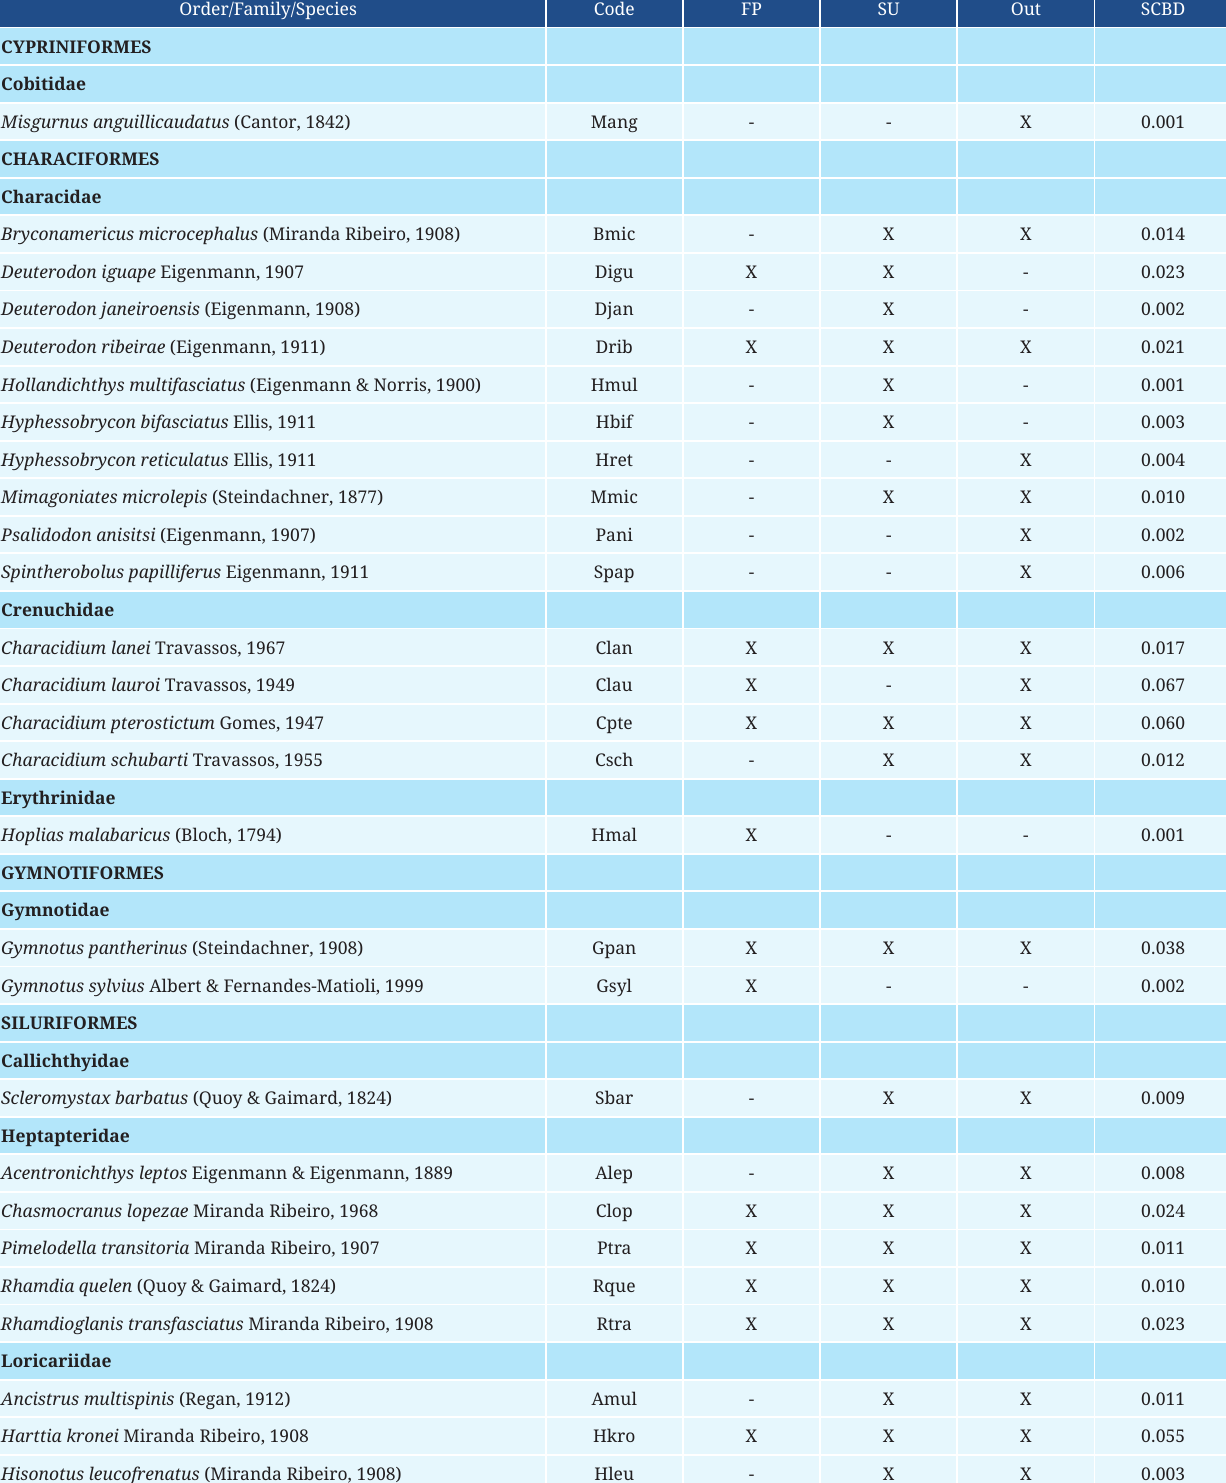
TABLE 1 | List of captured species from Serranias Costeiras of the Ribeira de Iguape River basin. Protected Areas: Full protection (FP), sustainable use (SU), and outside (Out). Species contributions to beta diversity